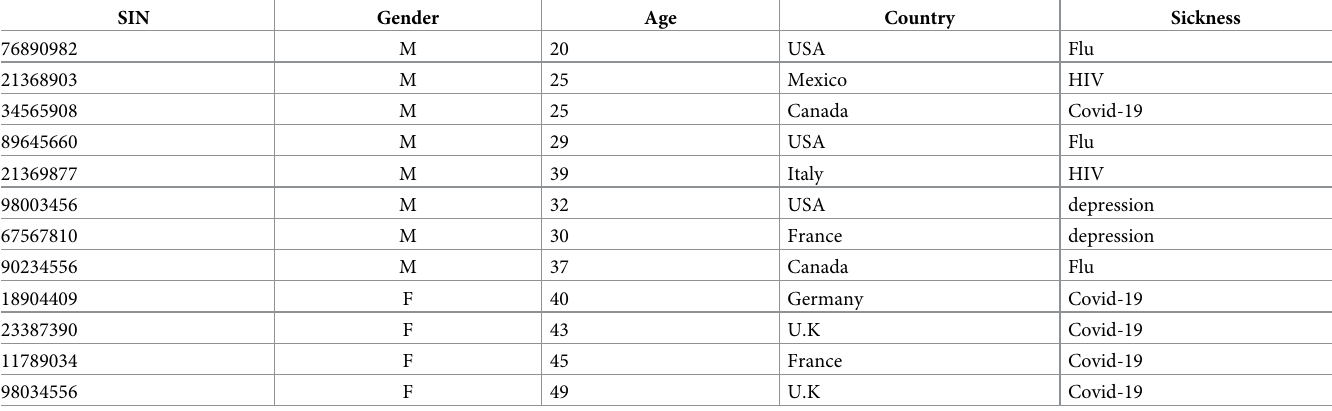
Table 1. A sample medical